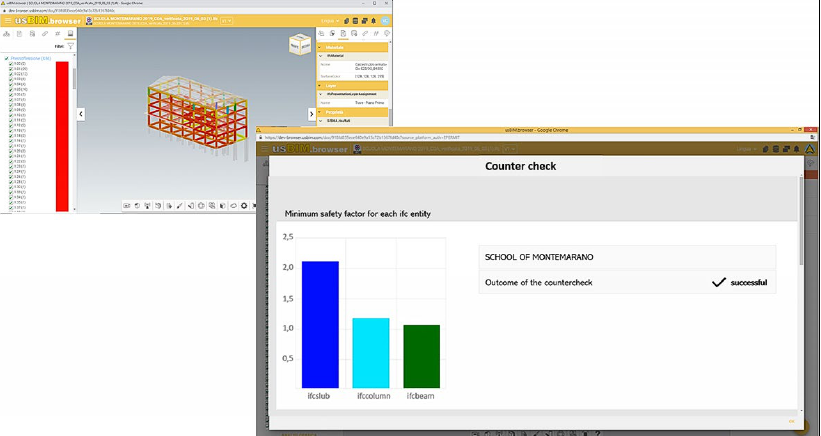
Figure 12. Example of the work of a civil engineering technician from a Building Regulatory Body using the Str.E.Pe